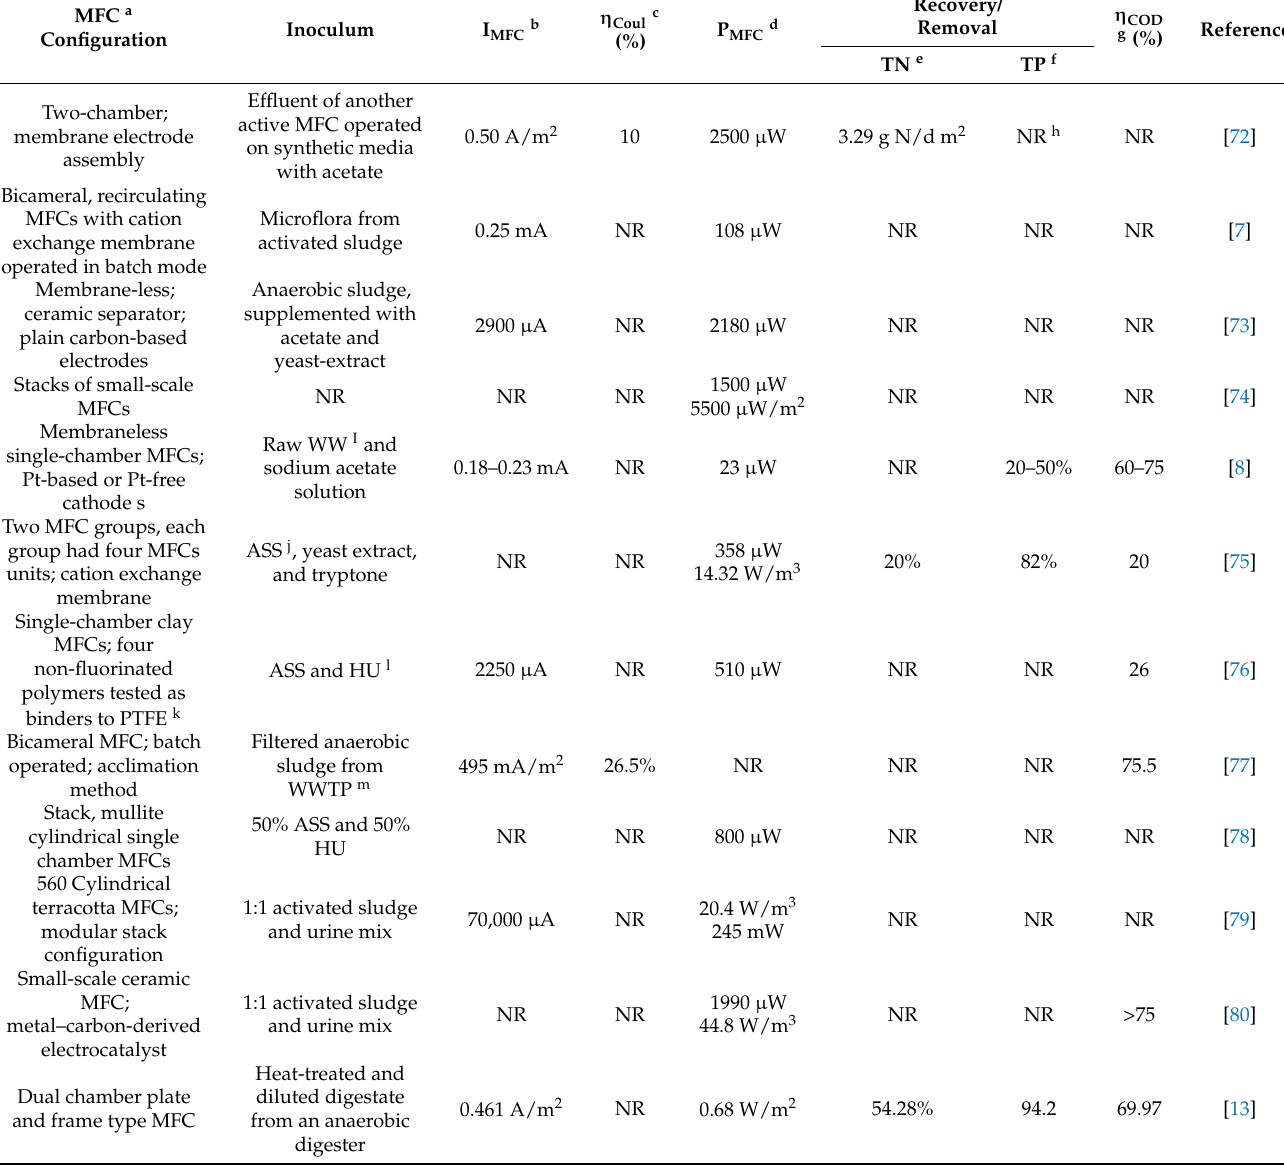
Table 3. Microbial fuel cells operating with actual human